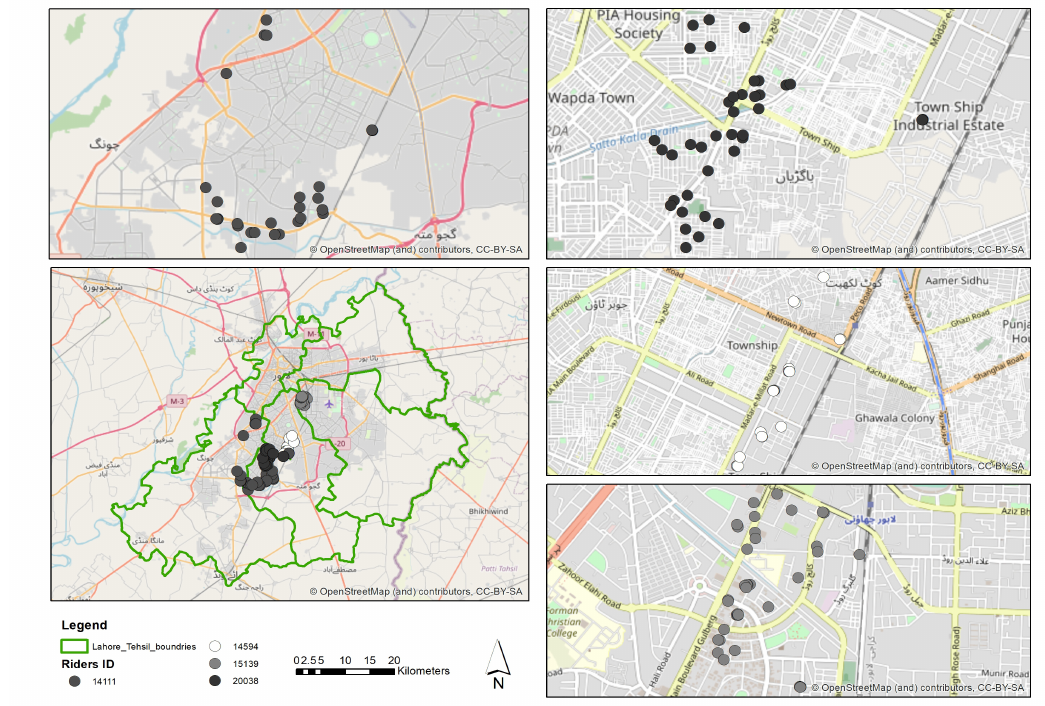
Figure 2. Spread of deliveries on 2021-09-13